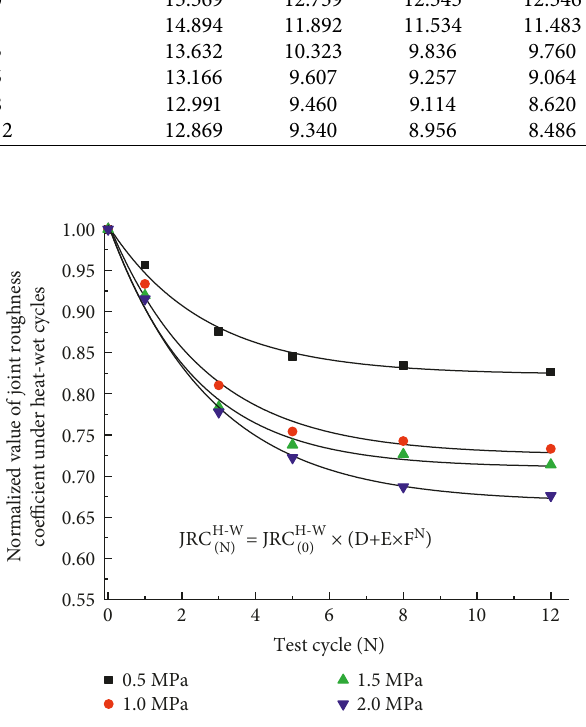
Figure 11: Deterioration curve of JRC under heat-wet